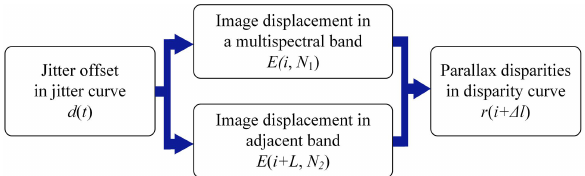
Figure 3. Workflow of the integration imaging model